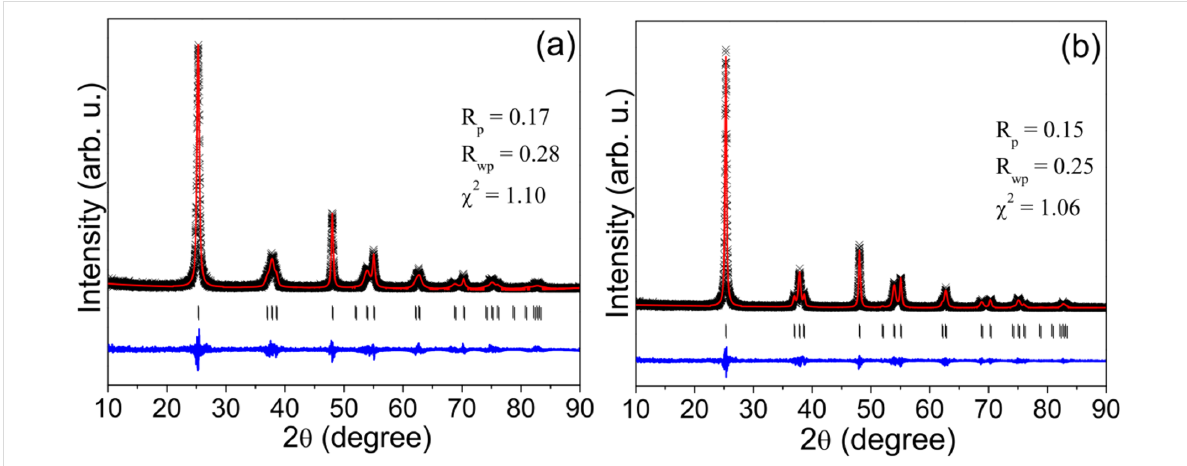
Figure 1: Experimental (×) and calculated (—) X-ray powder diffraction patterns of 1-S0 (a) and 2-S2 (b). Peak positions are shown as small markers (|). The lower trace represents the difference between the calculated and experimental